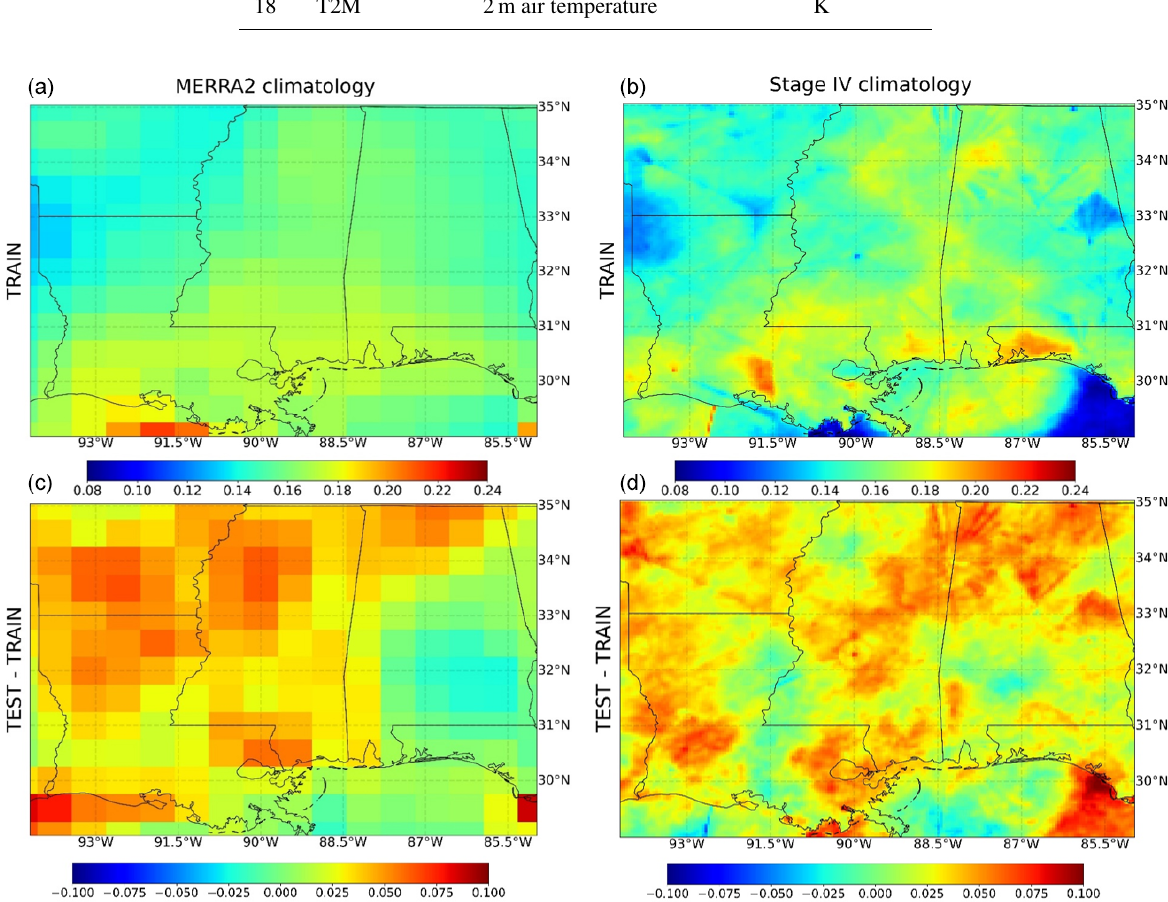
Figure 2. Climatology of hourly precipitation (in a unit of mmh − 1 ) from MERRA2 and Stage IV during the training period (2002–2015; first row) and their differences (second row) between the testing (2019–2021) and training